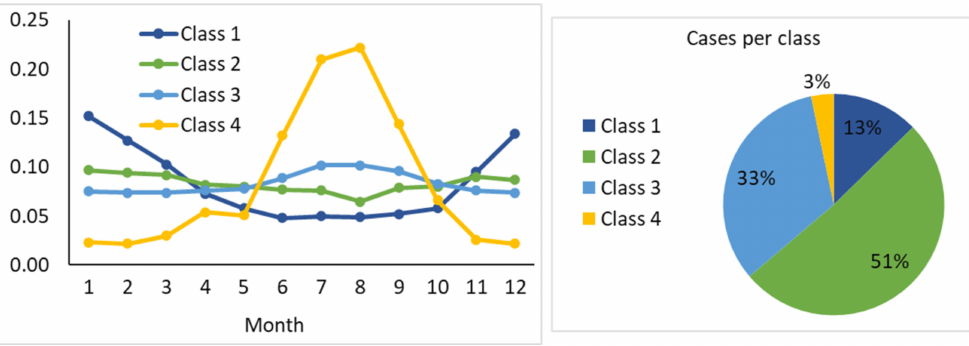
Figure 16. Four prototypes for month patterns defined by a range of 33,858 available installations.